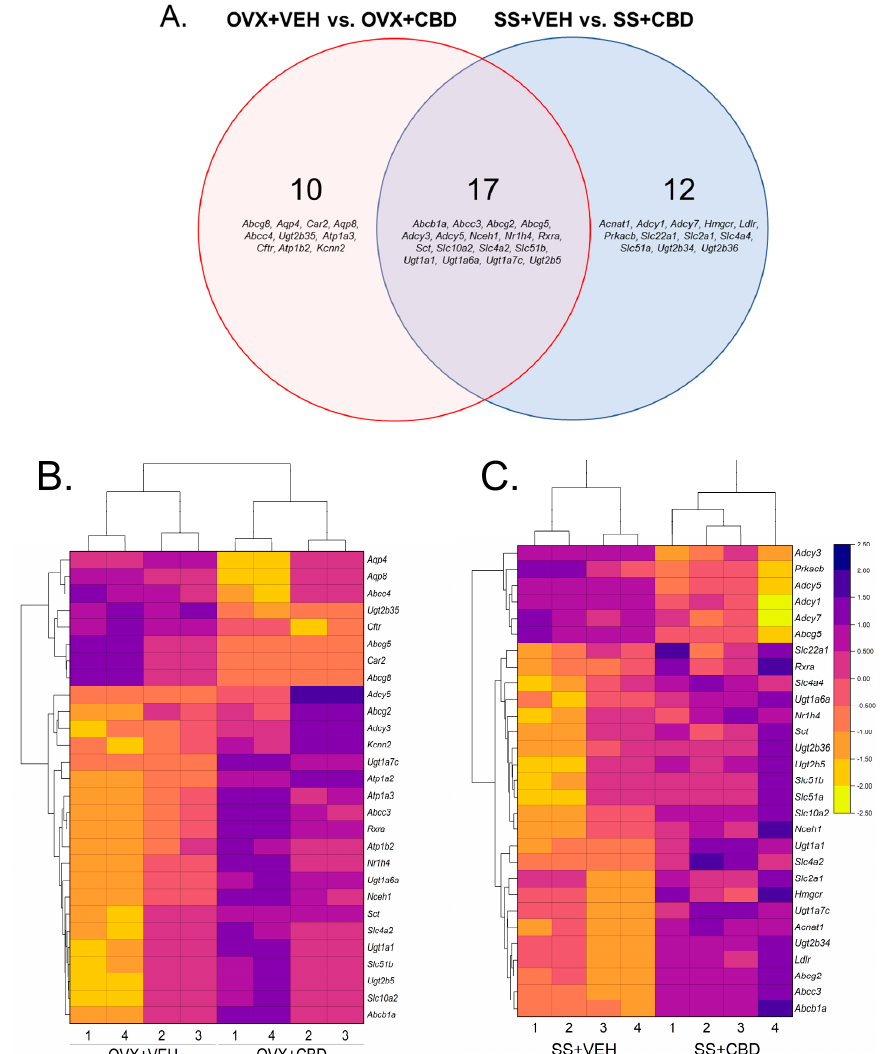
Figure 2. Differentially expressed bile secretion genes. ( A ) Venn diagram showing DEGs for indicated comparisons as well as DEGs that are in common between comparisons. DEGs held in common do not necessarily indicate the same direction of change. DEGs for ( B ) OVX+VEH vs. OVX+CBD and ( C ) SS+VEH vs. SS+CBD were generated based on Euclidean clustering. The Z-score scale indicates downregulated genes from 0 to − 2.5 (orange to yellow shades) and upregulated genes from 0 to 2.5 (red to purple/navy shades).